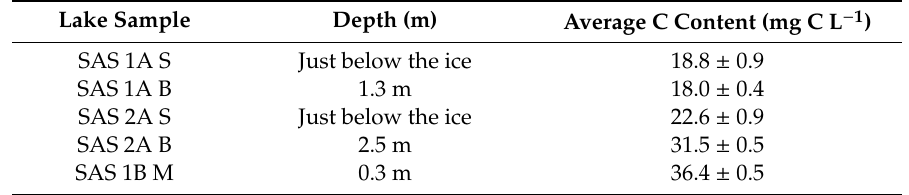
Table 2. Table containing the average C content in mg C L − 1 ( ± SD) for each of the dissolved organic matter (DOM) samples. S: surface samples; M: medium depth samples; B: bottom